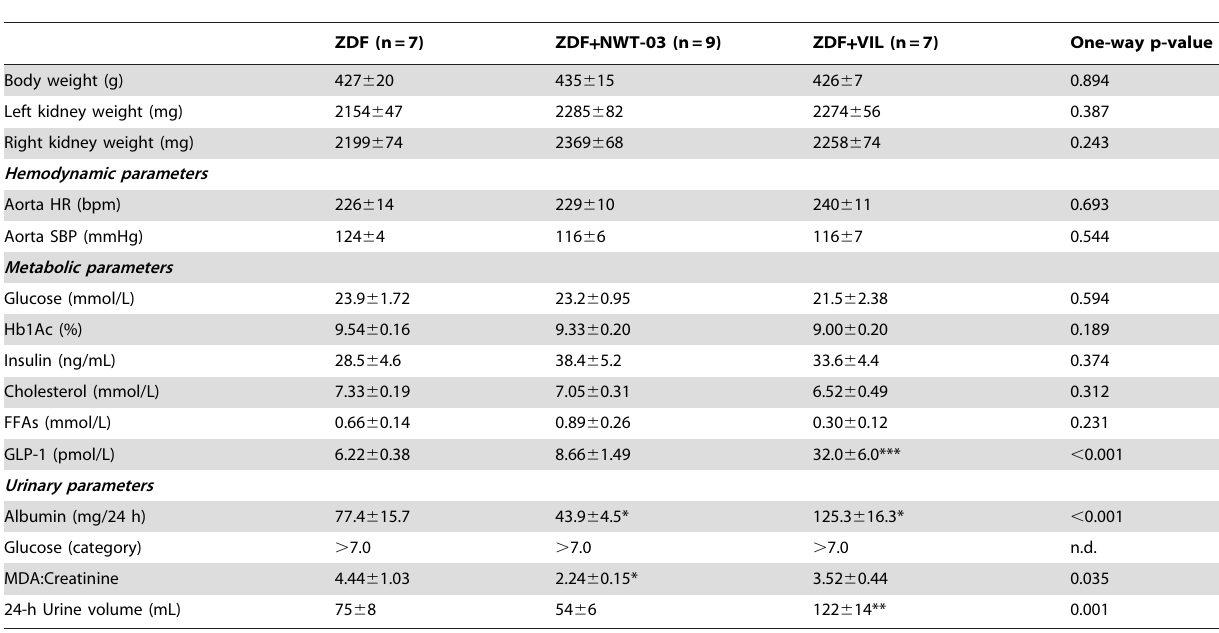
Table 2. Characteristics of 25-week-old ZDF rats after 15 weeks of